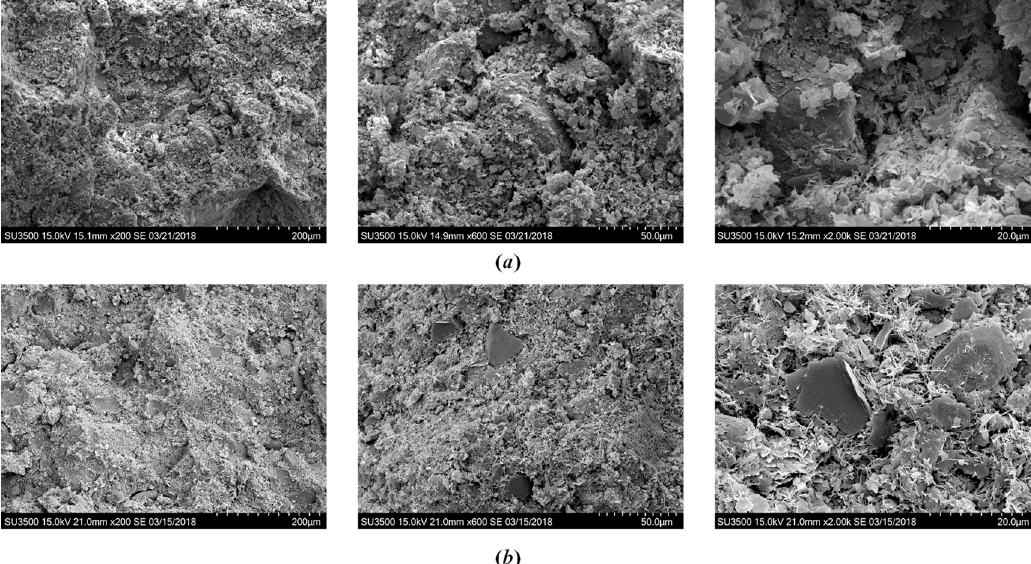
Figure 11. SEM images showing the effect of lime content after 28 days of curing: ( a ) A p = 1‰, A L = 7% ( b ) A p = 1‰, A L = 12%.